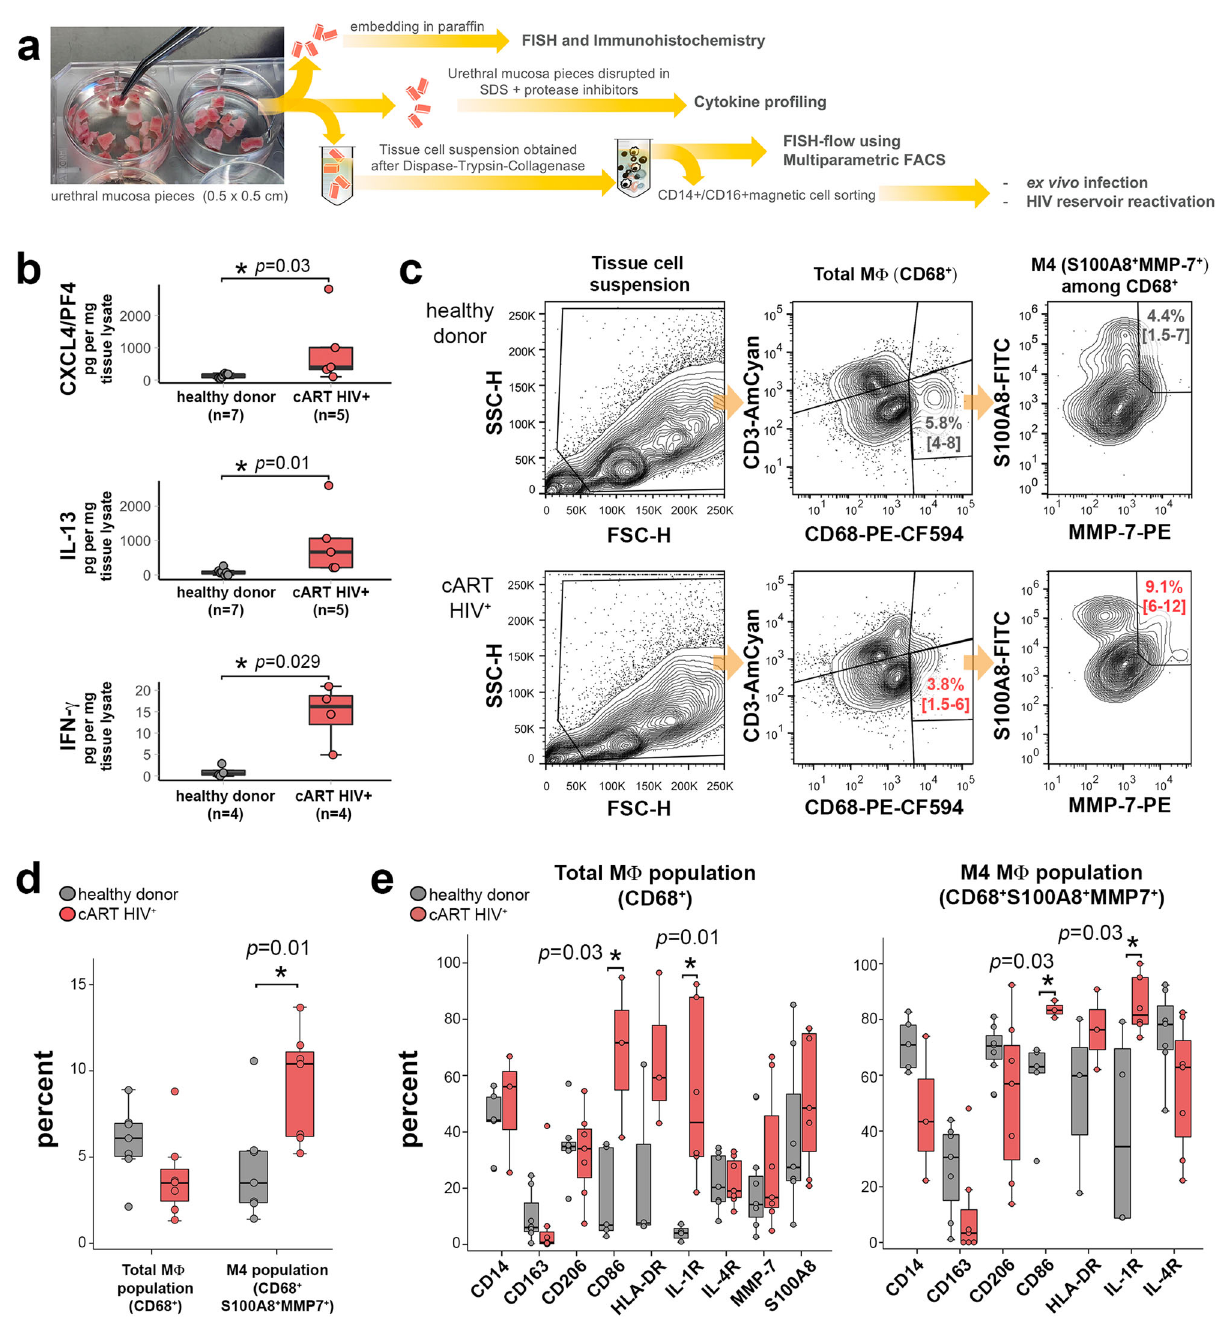
Fig. 1 | In fl ammatory M4-macrophages are enriched in the urethral mucosa of cART-suppressedHIV-1-infectedindividuals.a Schemeofthedifferentmethods applied to evaluate morphologically and functionally the mucosal macrophage HIV reservoir, from processing 0.5×0.5cm mucosal tissue pieces obtained from individuals that underwent gender reassignment. b CXCL4/PF4, IL-13, and IFN- γ cytokine pro fi le of urethral tissue extracts of healthy donors (gray) and cART- suppressed HIV-infected (cART HIV + ) individuals (red). The number of individual samples ( n ) included in the analysis is shown per group and cytokine tested. Mann – Whitneytestperformedforpairwisecomparisonsbetweenthetwogroups of individuals and per cytokine. Source data are provided in Source Data fi le. c FlowcytometrygatingstrategyforcharacterizationofM4-macrophagesubtype in healthy donors (upper example) and cART-suppressed HIV-infected indivi- duals (lower example). From CD68 + CD3 neg events (total M Φ ), M4-macrophages